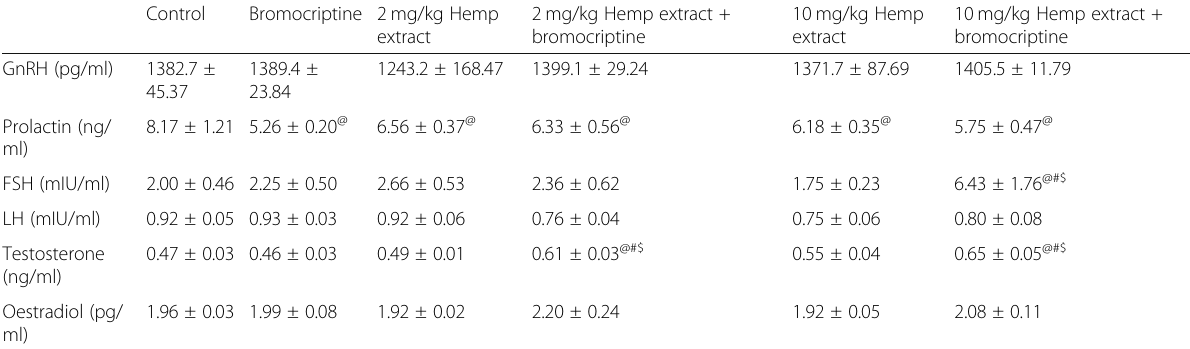
Table 2 Effects of bromocriptine and/or BHE on reproductive hormones in male rats